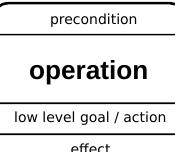
Figure 4. We use this graphical notation to visualize operations. For the operation j , the